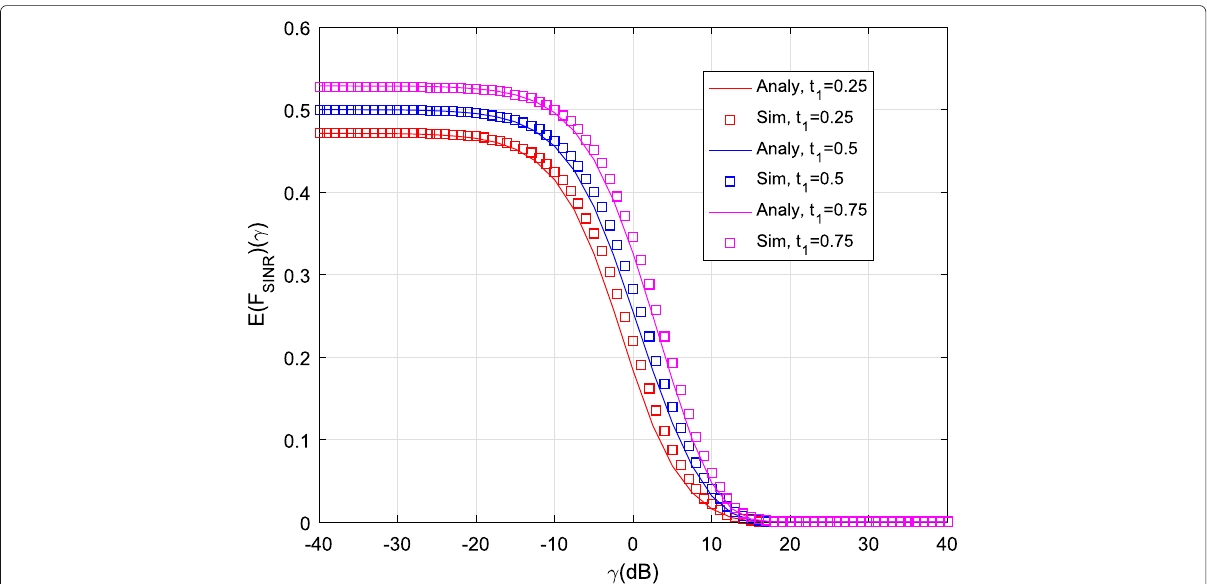
Fig. 13 CCDF of the SINR of the hybrid scheme for the typical MT with (cid:5) = 1, t ( 1 ) / t ( 2 ) = 9 dB, p max → ∞ and i 0 = − 70 dBm